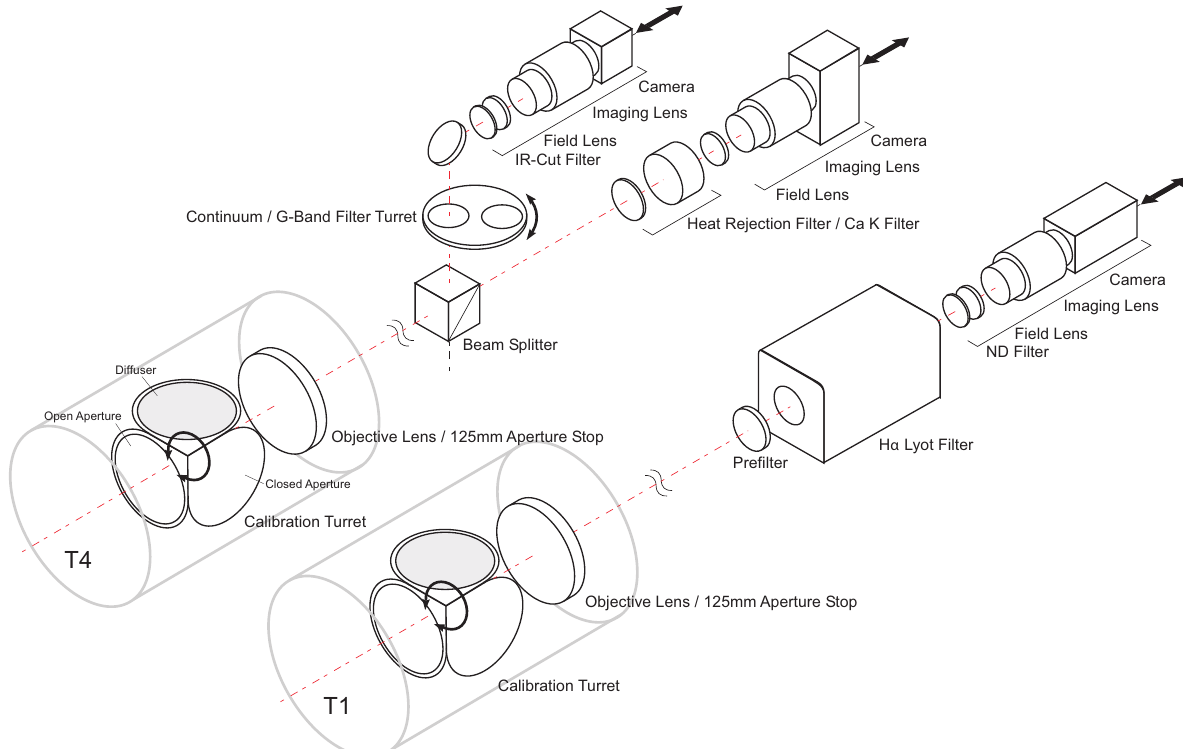
Fig. 3. Schematic diagram of the fi lter imager instruments installed in the rear sides of T1 (H a ) and T4 (Ca K, G-band, and continuum). Red dash-dot lines indicate the optical axes, while the arrows show motions of movable